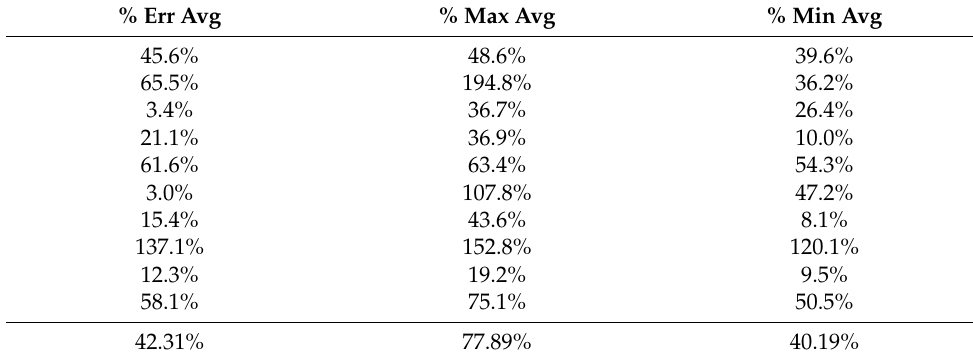
Table A41. Set 1, trials 21–30 data (actual PR value).